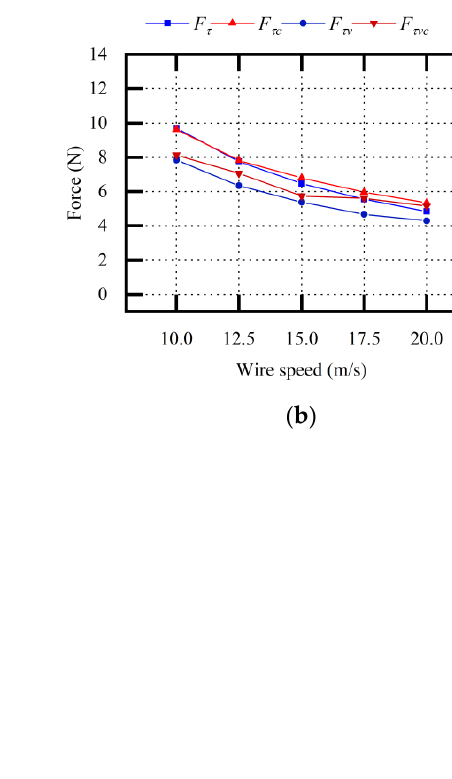
v  ): ( a ) normal sawing force; ( b ) tangen-